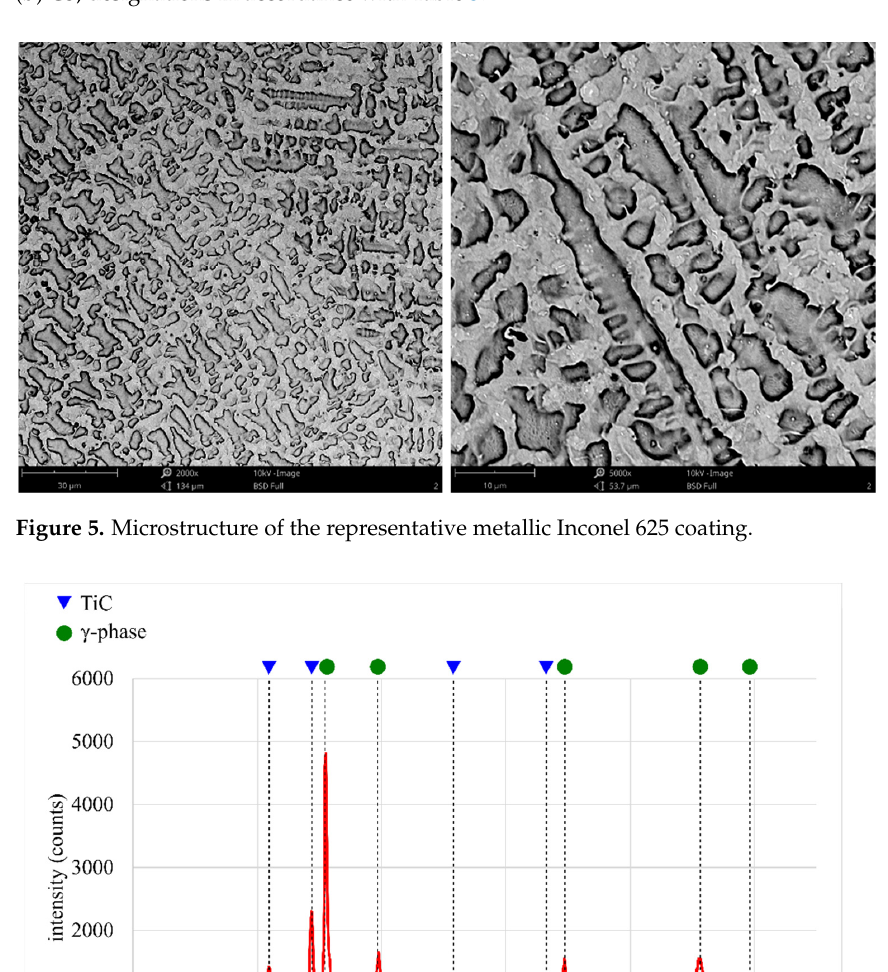
Figure 7. EDS maps of the composite Inconel 625/TiC coating matrix. The secondary phases formed in the matrix, characterized by blocky and dendritic morphology, revealed the gradient distribution of chemical contents (Figure 4). The EDS examination revealed that the inner, i.e., darker, part of the aforesaid phases contained a higher titanium content. It could be assumed that the TiC particles precipitated from the liquid metal and, afterwards, the atoms of Mo and Nb dissolved in the crystal lattice. Eutectic phases, which precipitated on the secondary phases, could be observed in the matrix. After the formation of the secondary phases, they served, during cooling, as the crystal nucleus for eutectic precipitates between the austenite dendrites. In the microstructure of the overlap areas located between consecutive beads (Figure 8), the austenite dendrites as well as the secondary and the eutectic phase precipitates could be observed in the matrix (as in the central bead areas). In addition, it was also possible to observe large dendritic precipitates, formed as a result of the higher TiC par- ticle dissolution triggered by the subsequent thermal cycle. In the aforesaid area, the TiC particles were more rounded and characterized by the lighter shell (composed of carbon, niobium, molybdenum and titanium—the same as in the dendritic precipitates (Figure